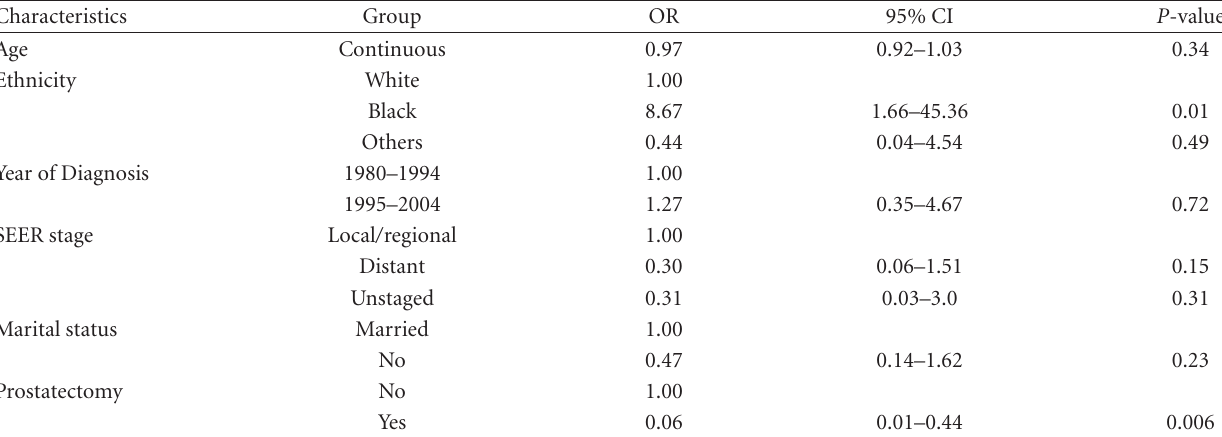
Table 4: Multivariate Analyses of Factors Associated with Receipt of Radiation in Patients with Signet Ring Prostate Carcinoma. Characteristics